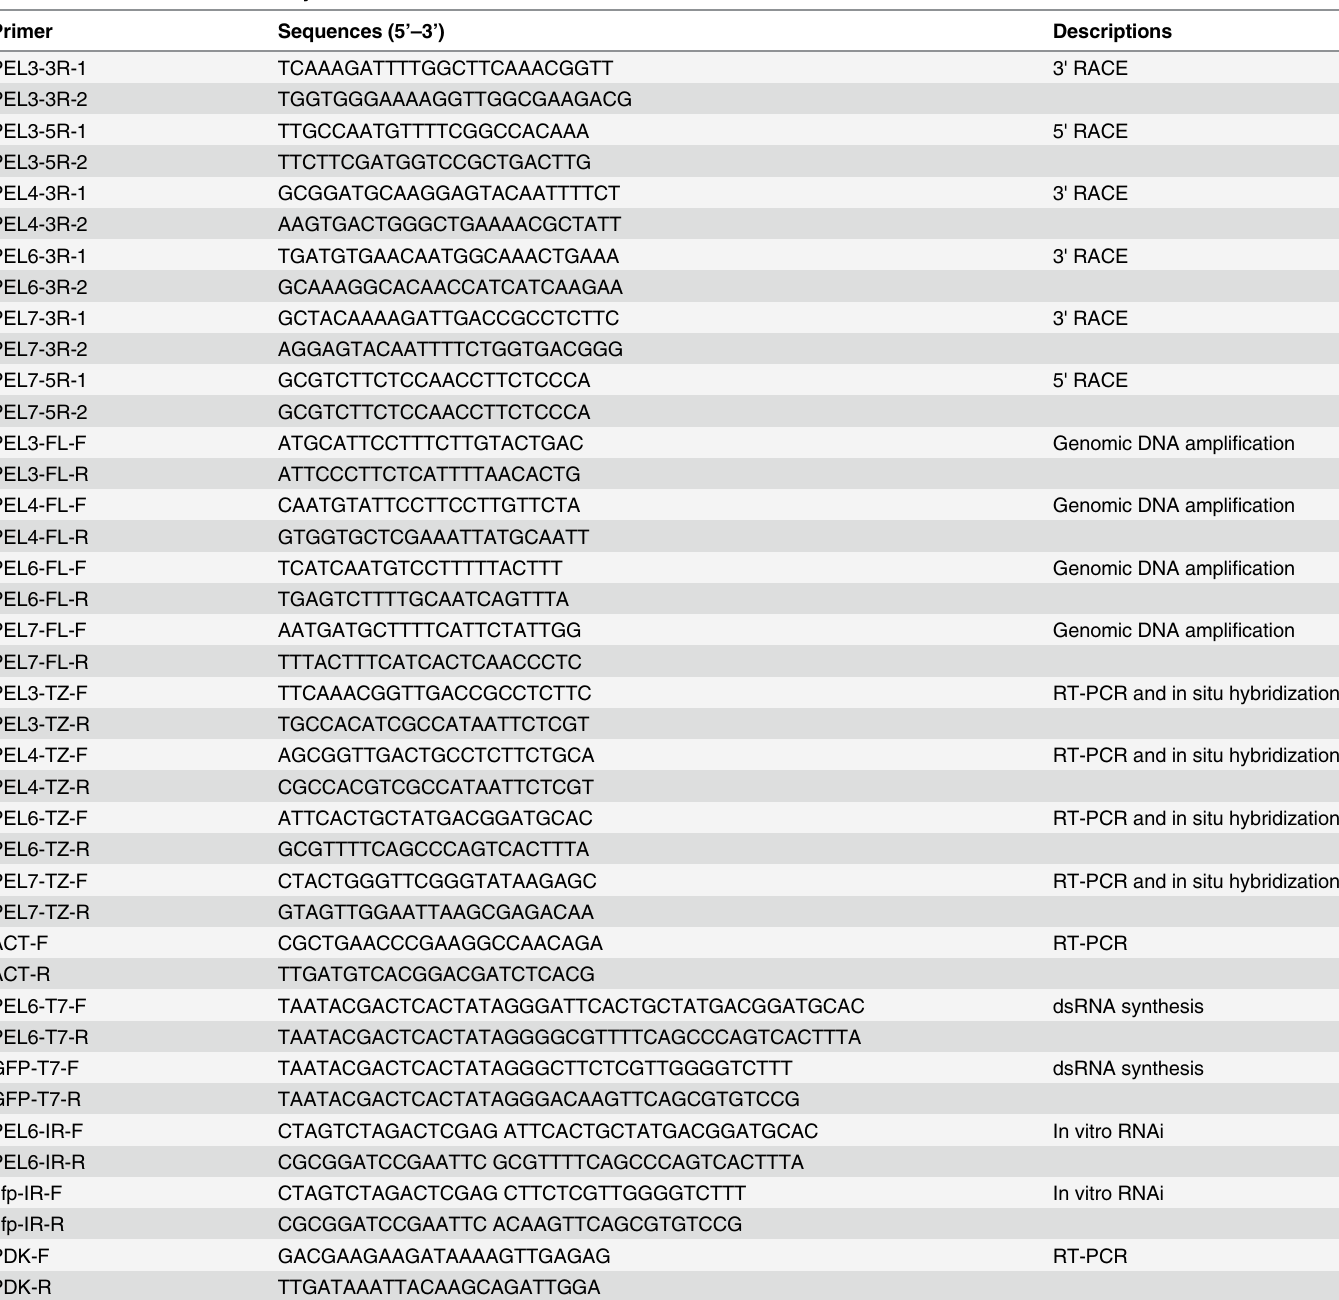
Table 2. Primers used in this